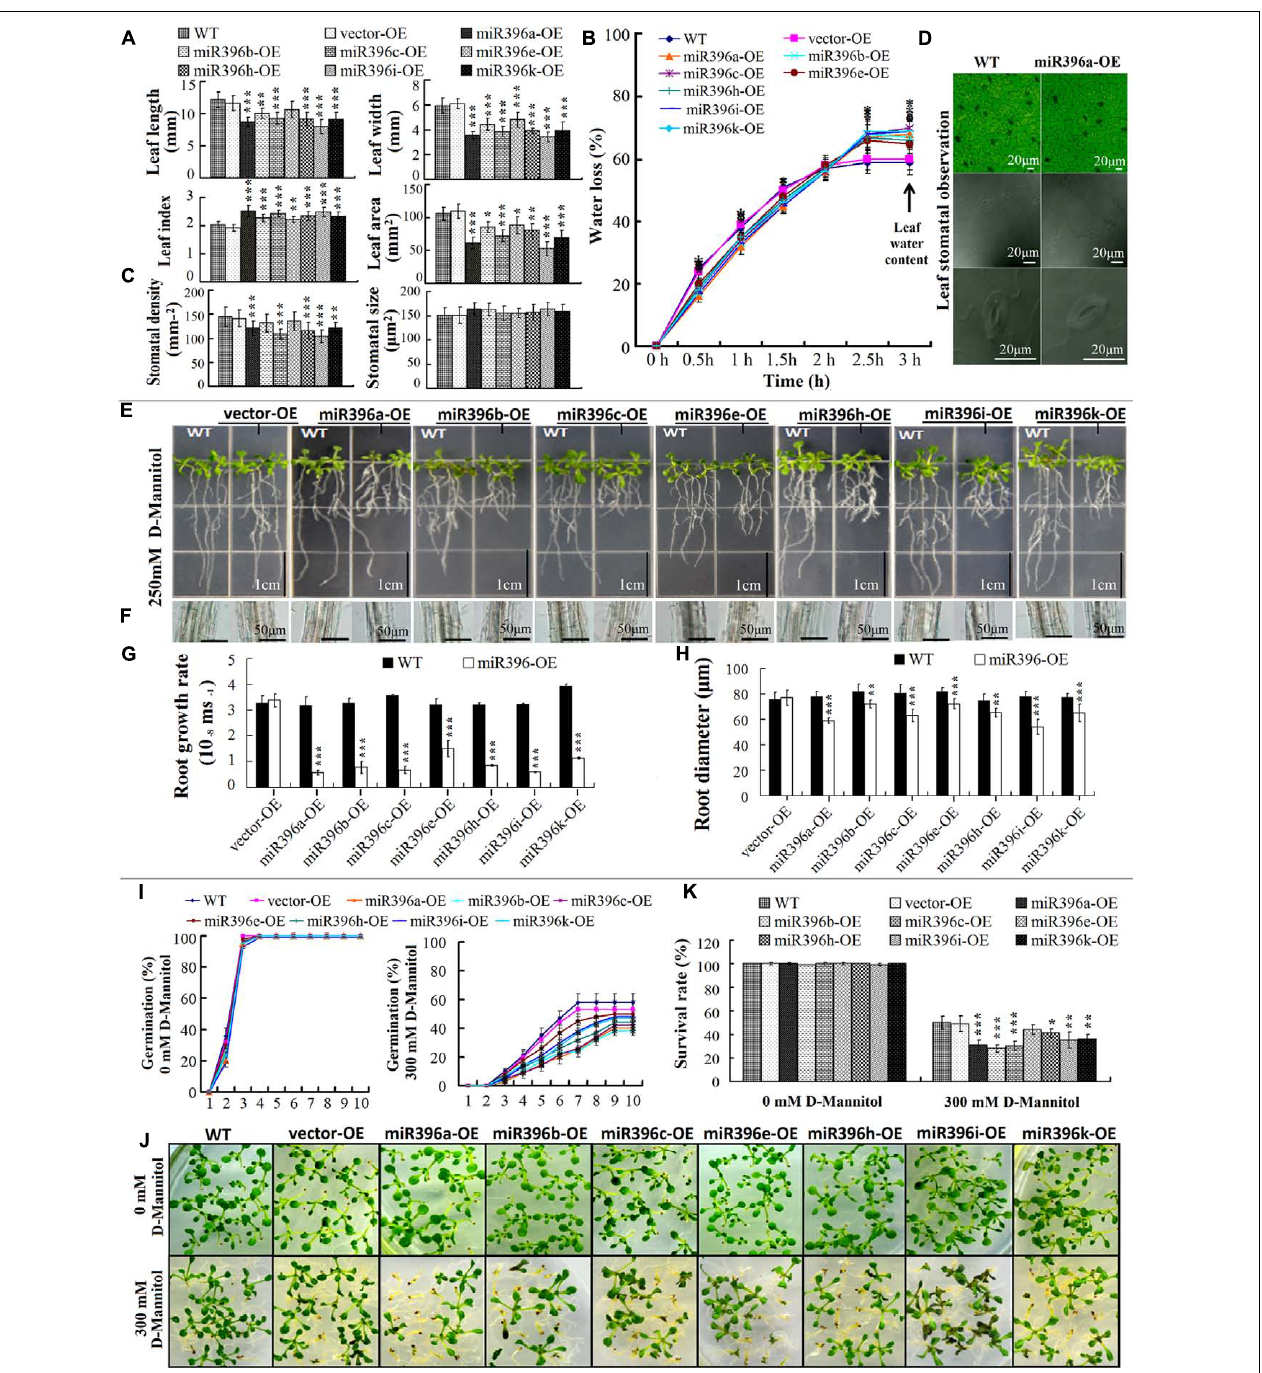
FIGURE 6 | Tissue-specific analysis of miR396a/b/c/e/h/i/k-OE transgenic Arabidopsis response low water availability. (A) Analysis for leaf length, width, index, and area; (B) Leaf water loss rate and water content; (C) Leaf stomata size and density; (D) Leaf stomata view (e.g., miR396a-OE). The data from (A) to (C) are average of 30 leaves ± SD, asterisks indicate significant difference applying ANOVA ( ∗ P < 0.05; ∗∗ P < 0.01; ∗∗∗ P < 0.001). (E) Root growth state of Arabidopsis cultured on 1/2 MS + 1% sucrose medium + 250 mM D-mannitol; (F) Cross section cut at half-way point of main root; (G) Root growth rate; (H) Root growth diameter. The data for (G) and (H) are average of 30 roots ± SD, asterisks indicate significant difference applying Student’s t -test ( ∗ P < 0.05; ∗∗ P < 0.01; ∗∗∗ P < 0.001). (J) Germination rate of Arabidopsis seeds in 10 days of cultivation on medium; (I) Arabidopsis seedlings grown on MS + 2% sugars + 0.8% agar and MS + 2% sugars + 0.8% agar + 300 mM D-mannitol medium for 10 days after germination; (K) Survival rate of Arabidopsis seeds after 10 days cultivation on medium. The data for (J,K) are average of three biological replicates ± SD (200 seeds per replicate). Asterisks indicate significant difference applying ANOVA ( ∗ P < 0.05; ∗∗ P < 0.01; ∗∗∗ P < 0.001).